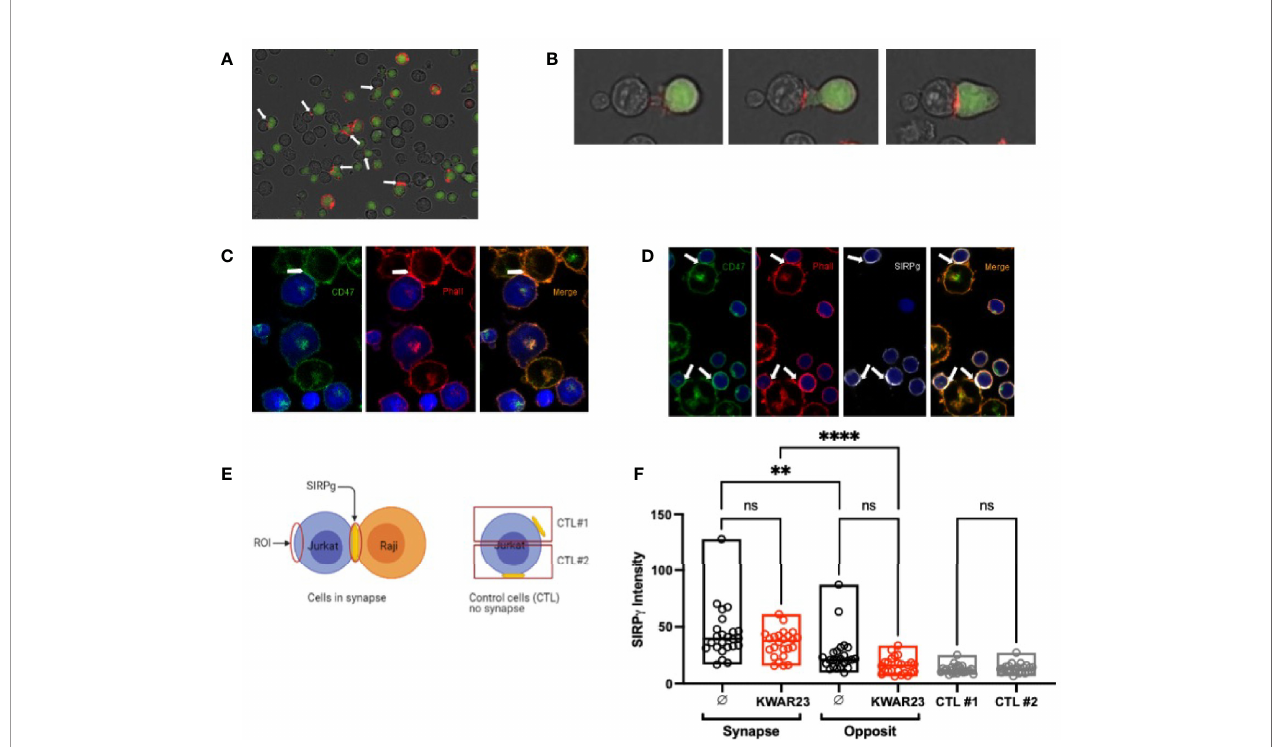
FIGURE 4 | SIRP g polarizes at the immune synapse. (A) Time-lapse microscopy of the polarization of SIRP g at the Raji-Jurkat cell contact. Jurkat cells were stained with the cell tracker (green) and an anti-SIRP g (red), and Raji cells (not stained) were primed with SEE; white arrows indicate SIRP g clusters at the Jurkat-Raji cell contact. (B) Similar culture condition as in (A) with several screenshots from a time-lapse video highlighting SIRP g cluster at the Jurkat-Raji cell contact. (C) SEE- primed Raji cells were stained with an anti-CD47 mAb (green). After the interaction with Jurkat cells (blue), cells were fi xed, permeabilized, and stained with phalloidin (red) which shows a polarization of actine at the Raji-Jurkat cell contact, indicating a synapse formation. Green staining also shows a polarization of the CD47 of Raji at the synapse. (D) Similar culture condition as in (A) but with T cells instead of Jurkat cells. T cells (blue) were stained with anti-SIRP g mAb (white), and Raji cells were stained with anti-CD47 mAb (green). After the interaction, cells were fi xed, permeabilized, and stained with phalloidin (red). Phalloidin staining shows the polarization of actine in the immune synapse as well as SIRP g and CD47. (E) Description of the methodology is used to analyze the expression of SIRP g regarding cell situation. (F) Histograms showing SIRP g intensity on Jurkat cells interacting or not (control (CTL)) with SEE-primed Raji cells in the presence or not of KWAR23. n = 5 to 10 cells analyzed per group from three independent experiments. Statistical analysis was performed by a Mann-Whitney test; ** p ≤ 0.01; **** p ≤ 0.0001, ns, not signi fi